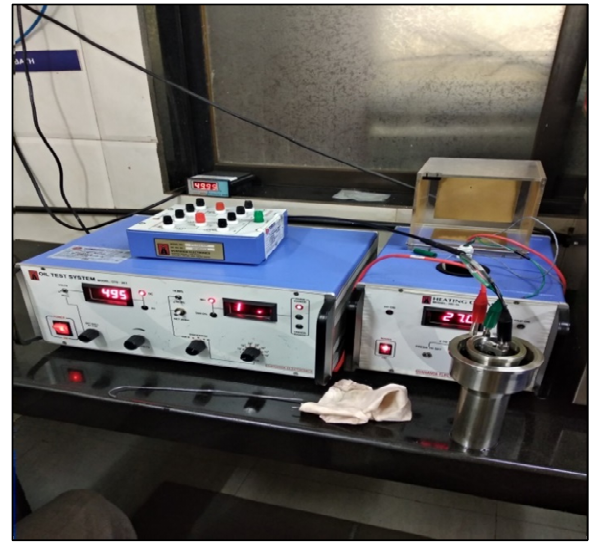
Figure 2. Oil resistivity and dissipation factor test apparatus.